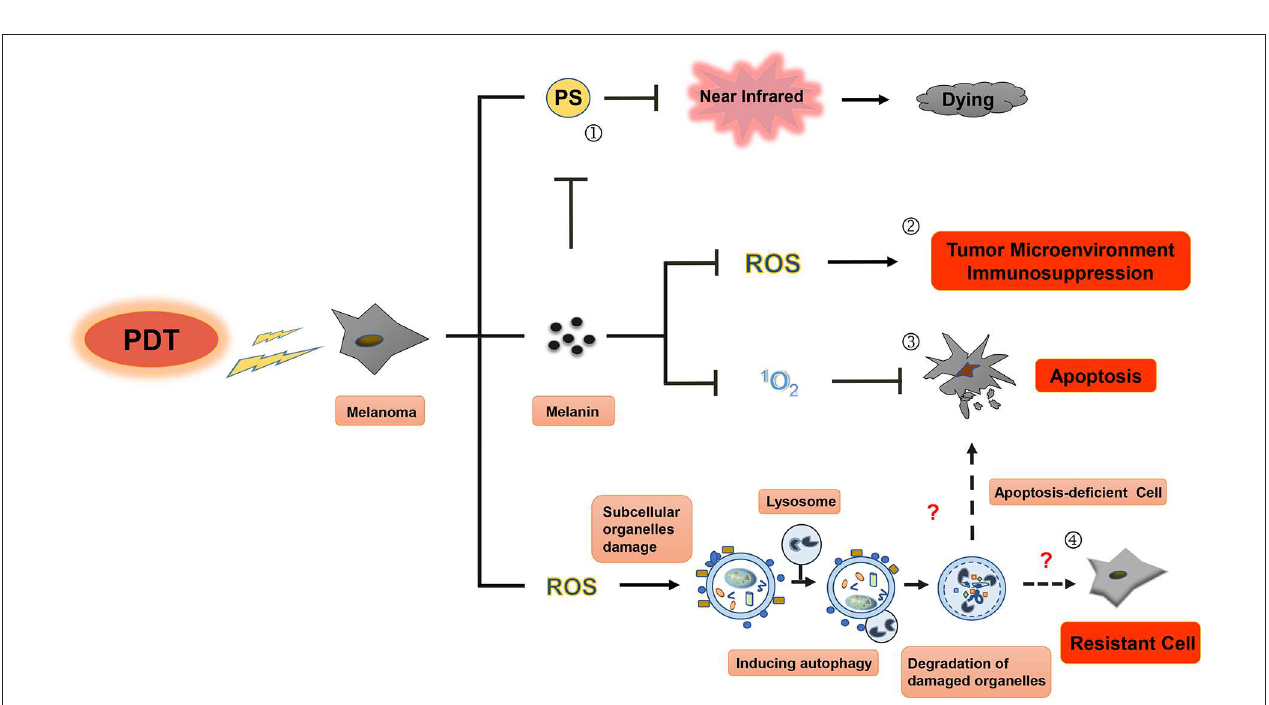
FIGURE 3 | Resistance mechanisms during photodynamic therapy of melanoma. Photosensitizers cannot be effectively excited by near-infrared (NIR) in PDT for melanoma, melanin granules and autophagy could be the main contributors to this resistance. First, visible light can be absorbed by melanin in melanoma cell ( ‹ ), leading to diminishment of photothermal effect induced by PS and decrease in production of ROS and singlet oxygen, then resulting in the inhibition of immune response in tumor microenvironment ( › ) and apoptosis blocking ( fi ) of melanoma cell. Only in the near-infrared conditions, PS can play an even greater role in PDT treatment of melanoma. Second, subcellular organelle damage induced by ROS in PDT treatment can enhance autophagy to maintain cell homeostasis against apoptosis, which ultimately leads to the resistance to PDT treatment in melanoma ( fl ).